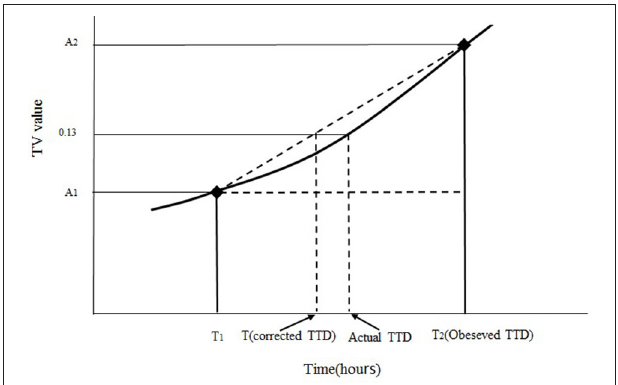
1 is the TV value of the last negative point at the time of T 1 , A 2 is the TV value of the first positive point at the time of T 2 , T is the corrected TTD of SEA. The curve with ( (cid:7) ) is the trend of TV value during